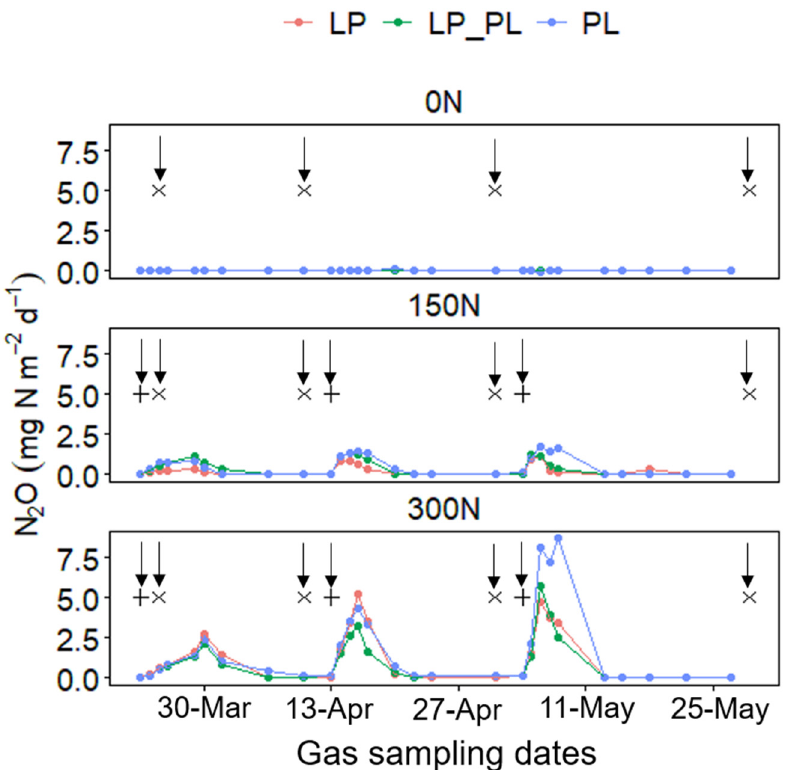
Figure 4. Graphs showing daily N 2 O fluxes from the diverse swards at different fertilization rates. LP represents Lolium perenne ; PL represents Plantago lanceolate . Arrows with + represent fertilizer application events, and arrows with x represent a biomass harvesting event. Table 2. Cumulative N 2 O emissions (83 days), as well as N 2 O emissions in relation to above- (AG) and belowground biomass (BG) among the different treatments.